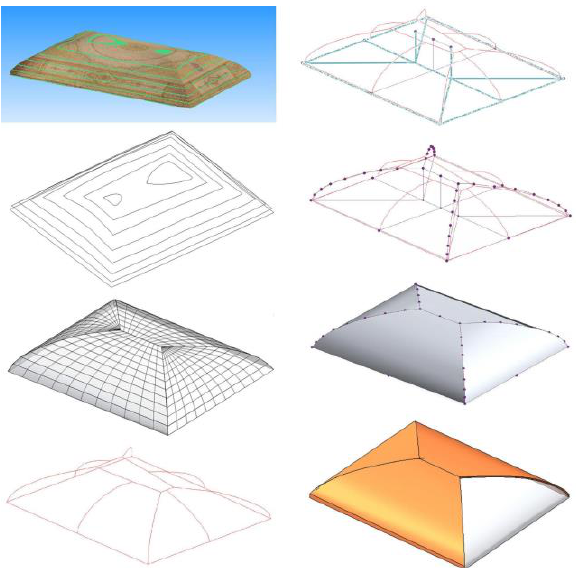
Figure 12. From the point cloud (upper left) to the re-topology and generator lines extraction. The mathematical is therefore converted in BIM model merging the “floor” component to the nails that allow to realize the pavilion